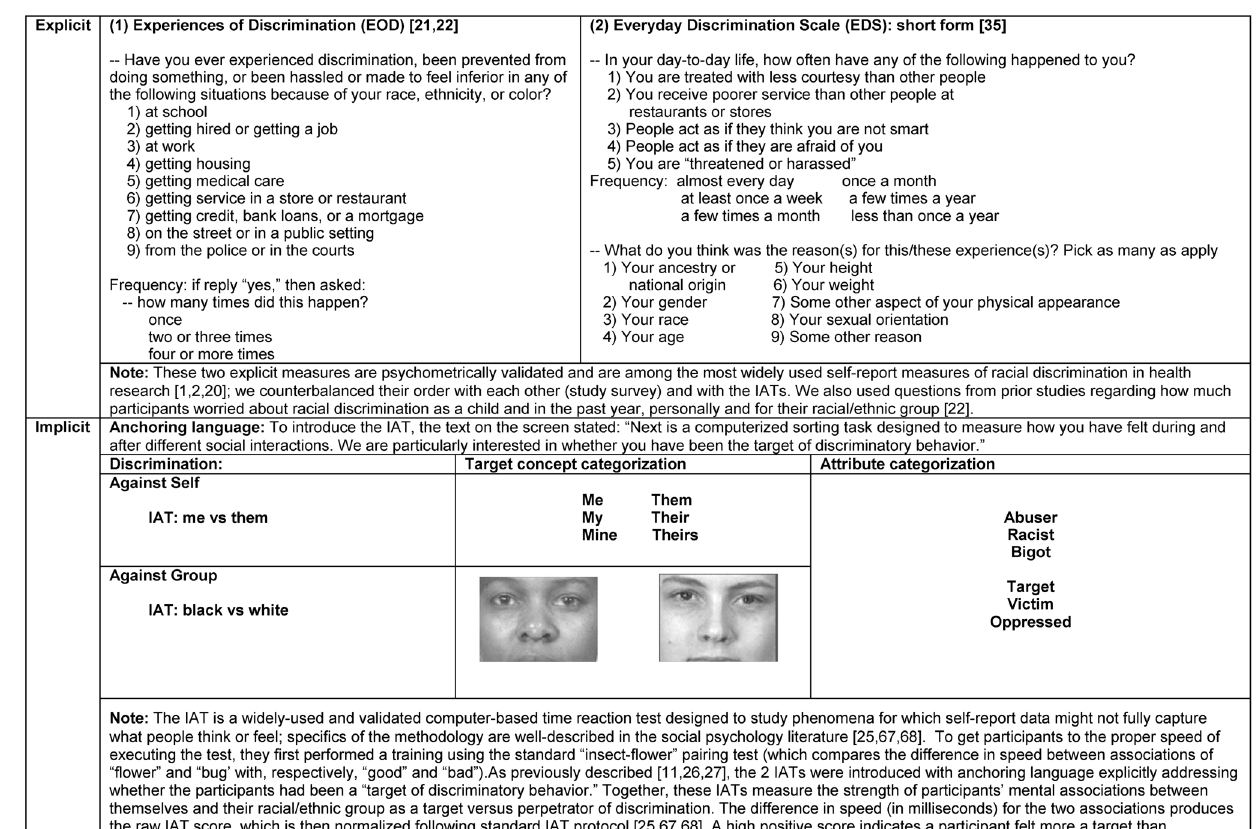
Figure 1. Measures of racial discrimination: implicit and explicit.